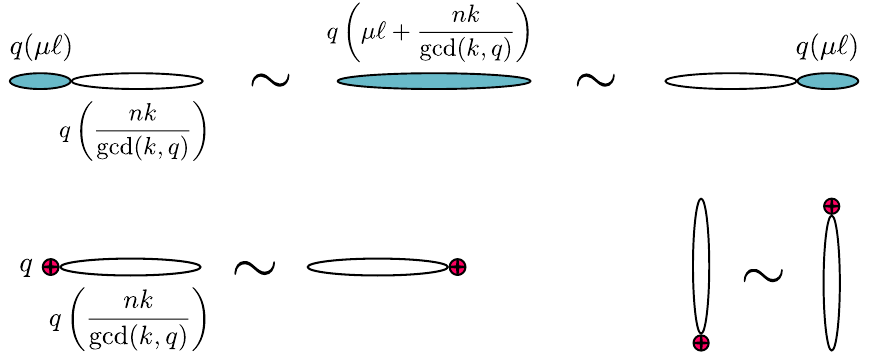
Figure 4: In the top, a dipole (the teal oval) can effectively “hop" in the direction along its dipole moment by merging it with a transparent dipole (i.e. one with dipole moment in k (cid:90) ) and condensing one from the other end. Below the same mechanism allows charge defects to hop in either